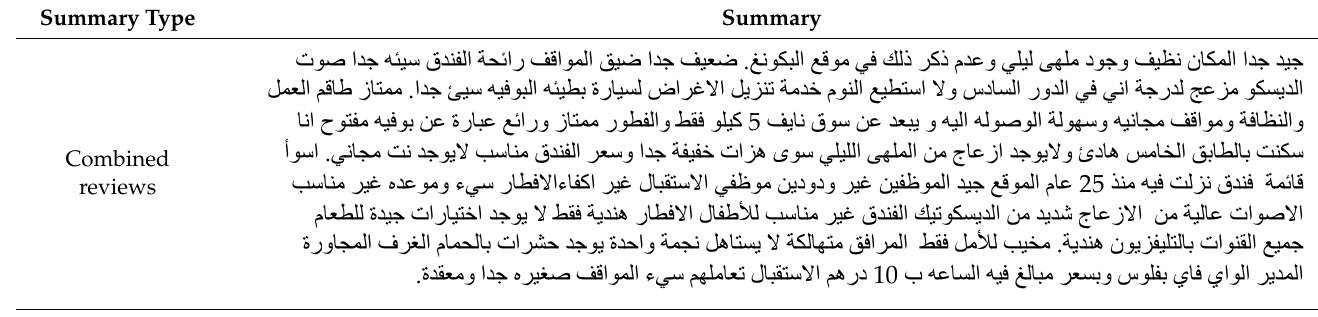
Table 7. Example of baseline and the proposed approach.